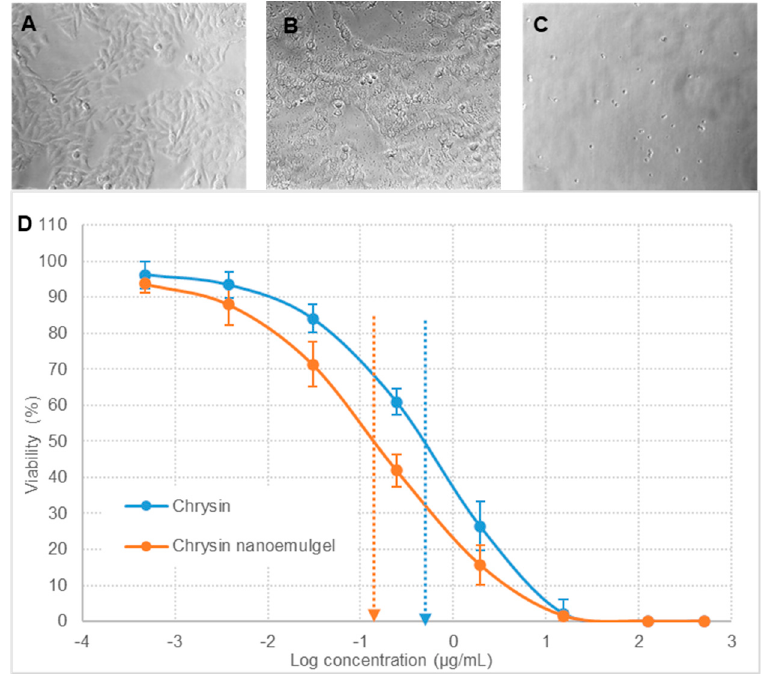
Figure 6. Morphological observation and growth inhibition of A375 cells. ( A ) control cells (untreated), ( B ) cells treated with pure chrysin, and ( C ) cells treated with chrysin nanoemulgel. Figure ( D ) represents the in vitro cytotoxicity profile, plotted as the viability of cells (%) versus the log of chrysin concentration ( µ g/mL). The data represented are mean values of 3 independent determinations, and error bars indicate standard error of triplicate analysis.